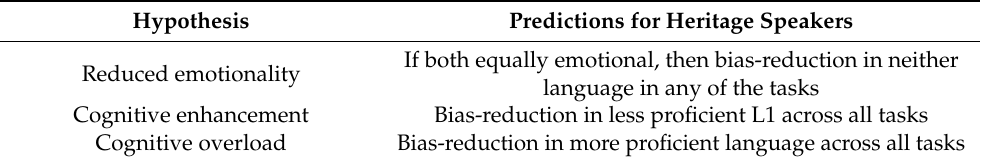
Table 18. Predictions from the